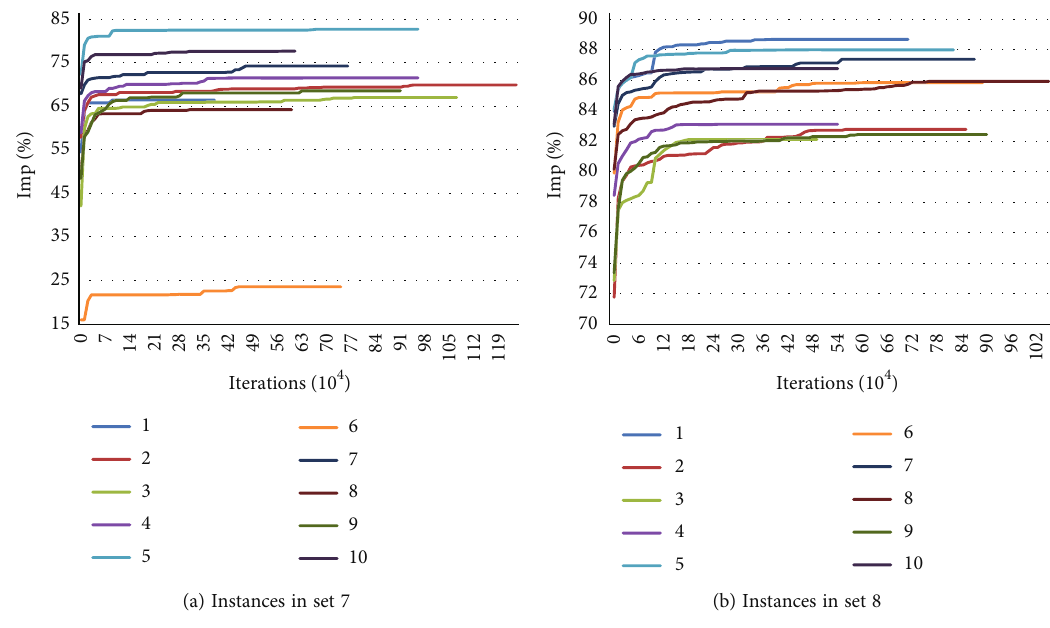
Figure 9: Convergence of the VNS algorithm on sets of instances 7 and